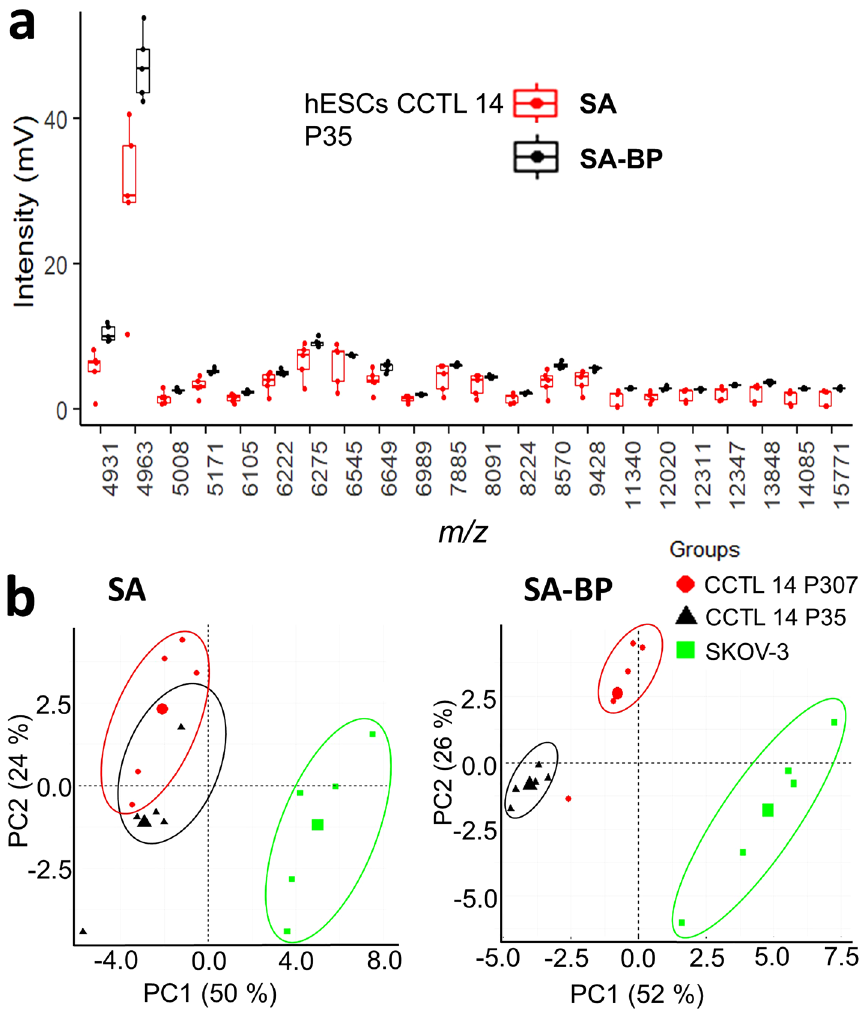
Figure 1. Enrichment of sinapinic matrix acid by black phosphorus improves reproducibility of mass spectra and discrimination analysis. ( a ) Averaged peak intensities ( n = 5) acquired from intact human embryonic stem cell line CCTL 14, passage number (P) 35. Box-plots show medians ± 25 and 75 quartiles of peak intensities obtained either with sinapinic acid (SA) matrix only (red) and with SA matrix enriched by black phosphorus (BP) (black). Outliers are defined as 1.5× interquartile range, ( b ) Principal component analysis (PCA) of spectral profiles acquired from hESCs CCTL 14 of P35 and P307, and ovarian cancer cell line SKOV3. Intact cell MALDI TOF MS was performed either using the SA matrix alone or SA matrix enriched by BP, in positive ion mode with laser energy 140 a.u. 100 spectral profiles were